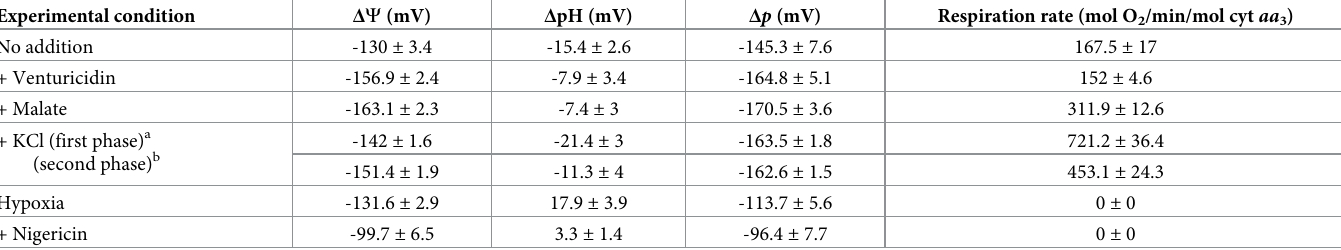
Mean ± SE of 6 ( Δ C and respiration rate) or 3 ( Δ pH and Δ p ) independent determinations. Reagents were sequentially added as shown in Fig 6. Δ p was not statistically different between the + Malate and the + KCl conditions (p = 0.13) according to a paired t-test. a The first phase corresponds to the average of the first 2 min after KCl addition. b Values for the second phase correspond to the average between 4 min after KCl addition and just before hypoxia.